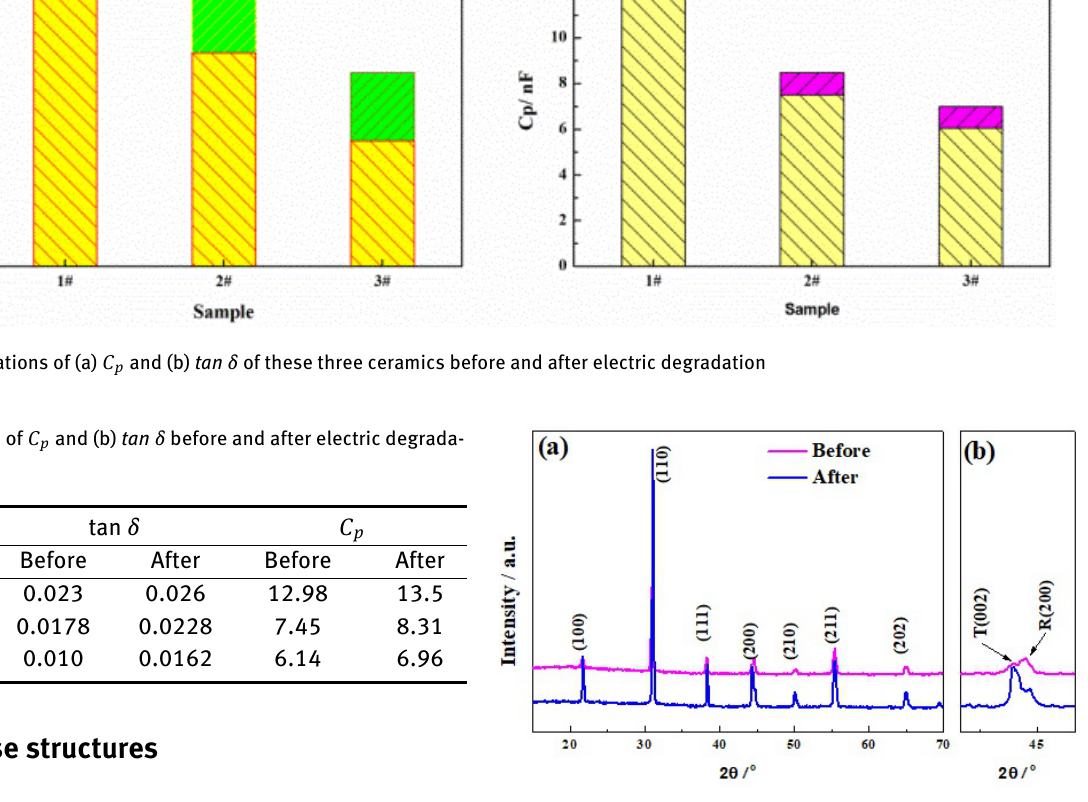
Figure 4: XRD patterns of sample 2# before and after electric degra- dation